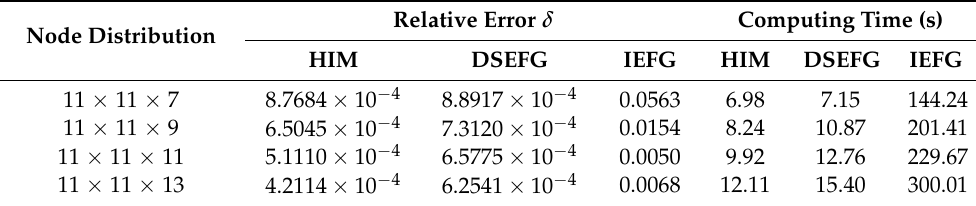
Table 4. Comparison of relative error and computing time when node distribution is different. Relative Error δ Node Distribution